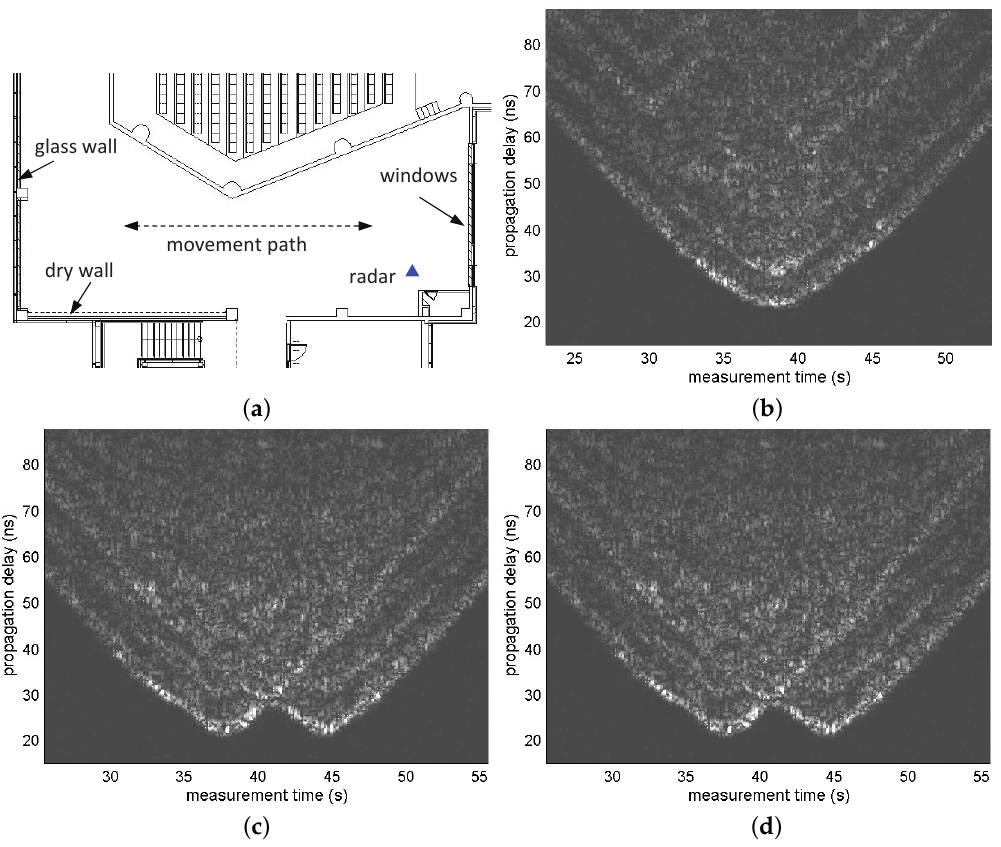
Figure 6. ( a ) Floor plan of the building where the experiments were conducted; ( b ) radargrams of Scenario 1. One target approached the radar and then moved away while the other repeated motions approaching the radar from a distance and returned back; ( c ) radargrams of Scenario 2. One target approached the radar and returned, and the other moved along the same path with a certain constant delay; and ( d ) radargrams of Scenario 3. Both targets approached the radar with some gap between them and moved away from the radar simultaneously.